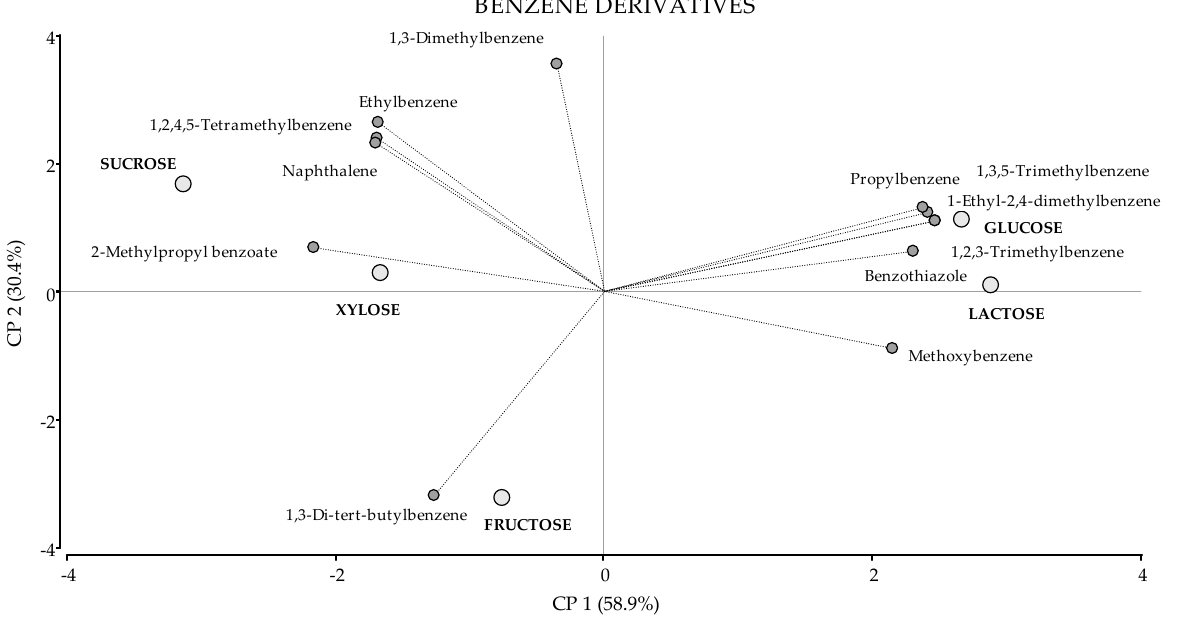
Figure 3. PCA of Benzene derivatives. A total of 17 variables were included: 12 VOCs (dark grey circles) and 5 carbon sources (light grey circles). The first two principal components accounted for 58.9% and 30.4% of the total variation, respectively.